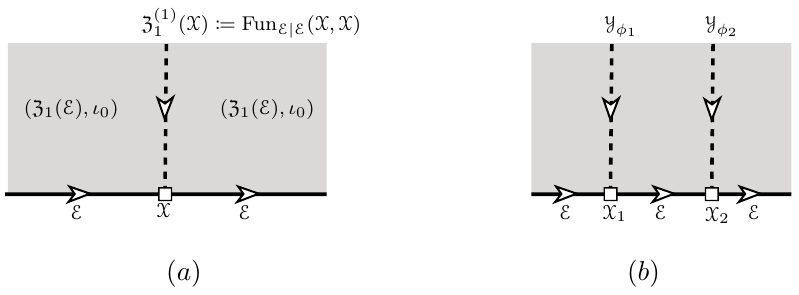
Figure 1 . Picture (a) illustrates the relation among E ; A ; X ; M in a physical way and provides